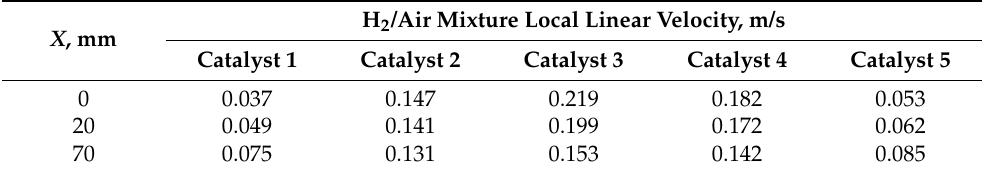
Table 2. Local linear velocity of a H 2 /air mixture, determined by CFD